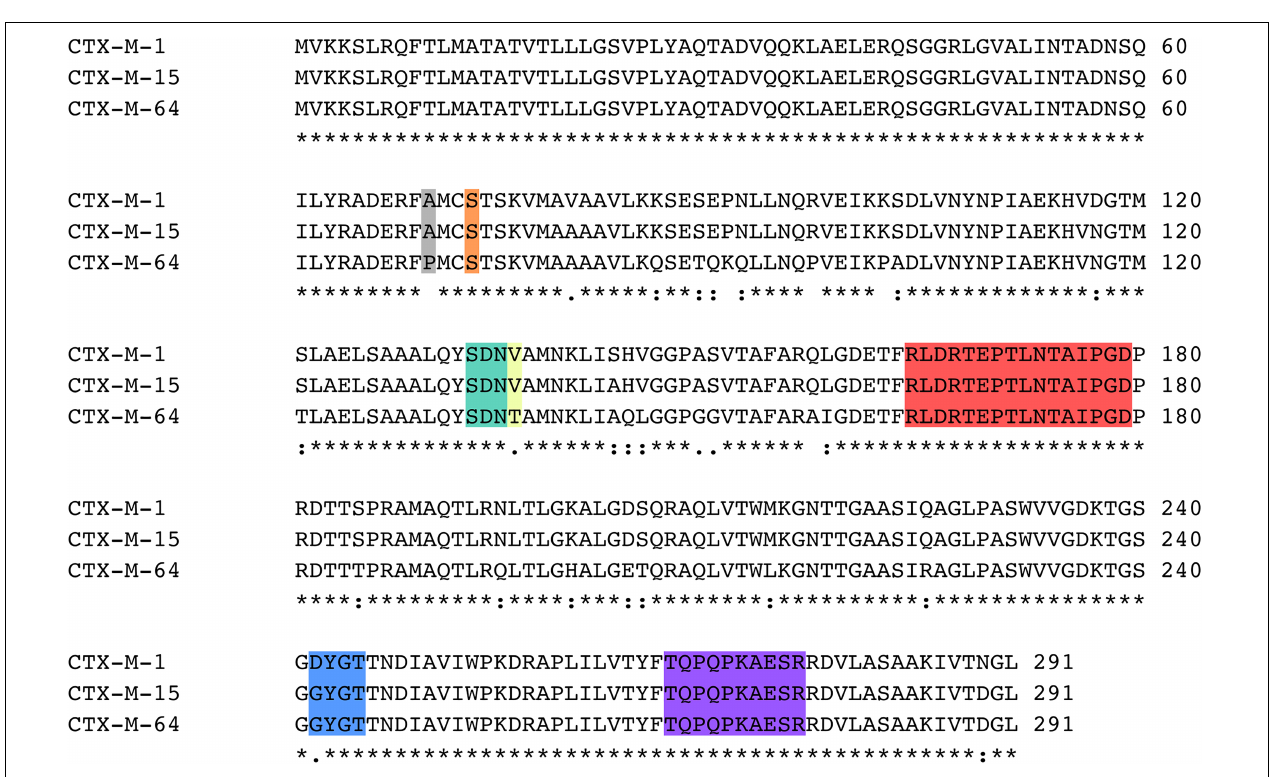
FIGURE 3 | Sequence alignment of CTX-M-1, CTX-M-15, and CTX-M-64. Key regions of the sequence are highlighted, including the A67P mutation site ( gray ), Ser70 ( orange ), the SDN-loop ( green ), the V133T mutation site ( yellow ), the (cid:127) -loop ( red ), the 240-loop ( blue ), and the 270-loop ( purple